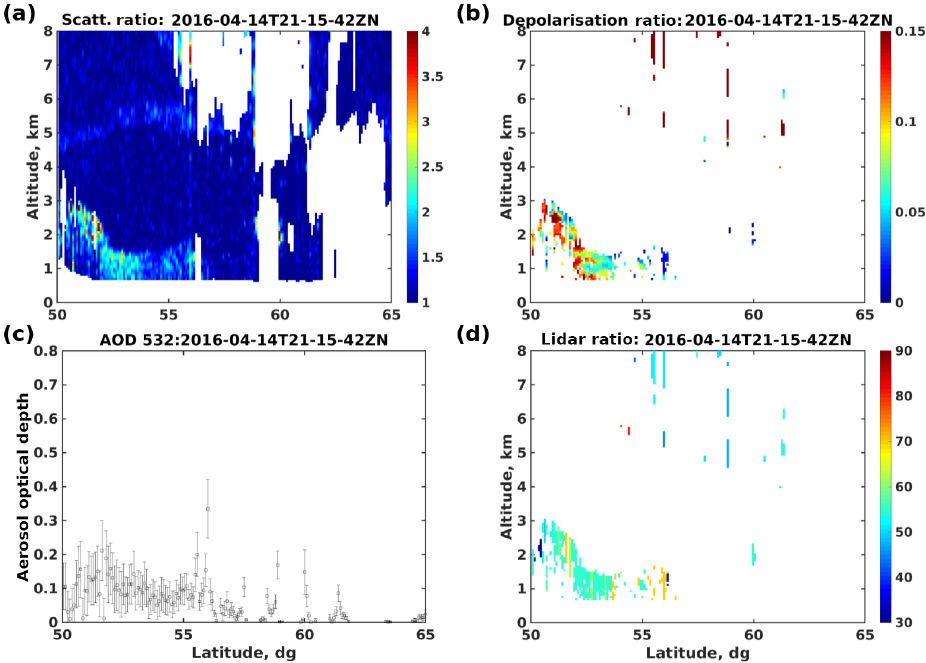
Figure 14. Latitudinal cross section of CALIOP 532nm scattering ratio R 532 (a) , aerosol depolarization ratio δ 532 (b) , aerosol optical depth AOD 532 (c) and lidar ratio S 532 (d) for 14 April